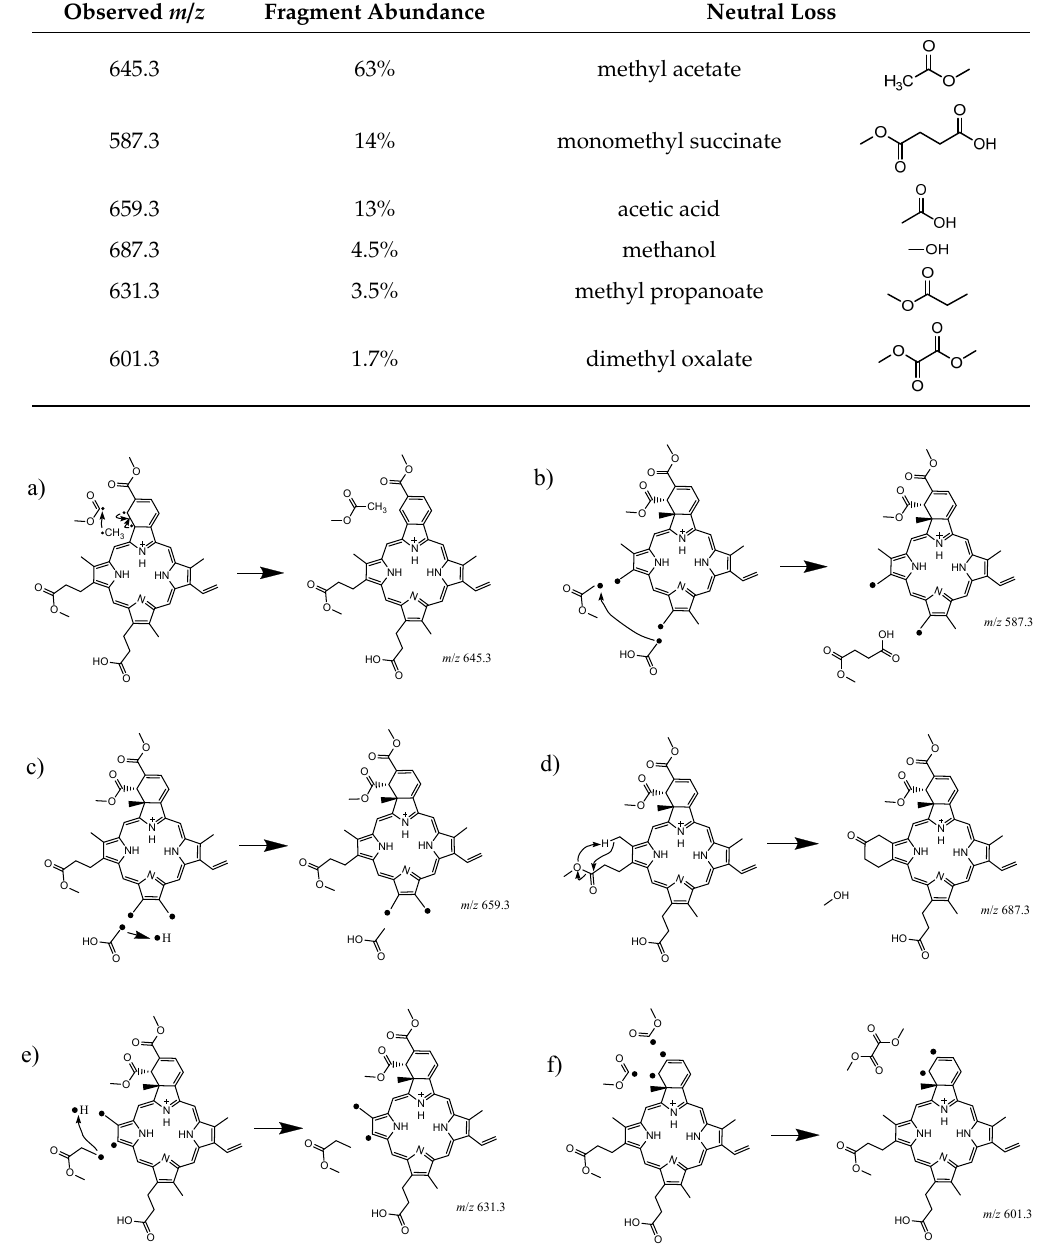
Table 1. Fragments derived from collision-induced dissociation (CID) on protonated verteporfin ( m / z 719.3). Fragment abundance is defined as MS peak intensity divided by the sum of all fragment peak intensities (Section S1). The proposed neutral fragment lost from protonated verteporfin is reported for each fragment, together with its chemical structure.